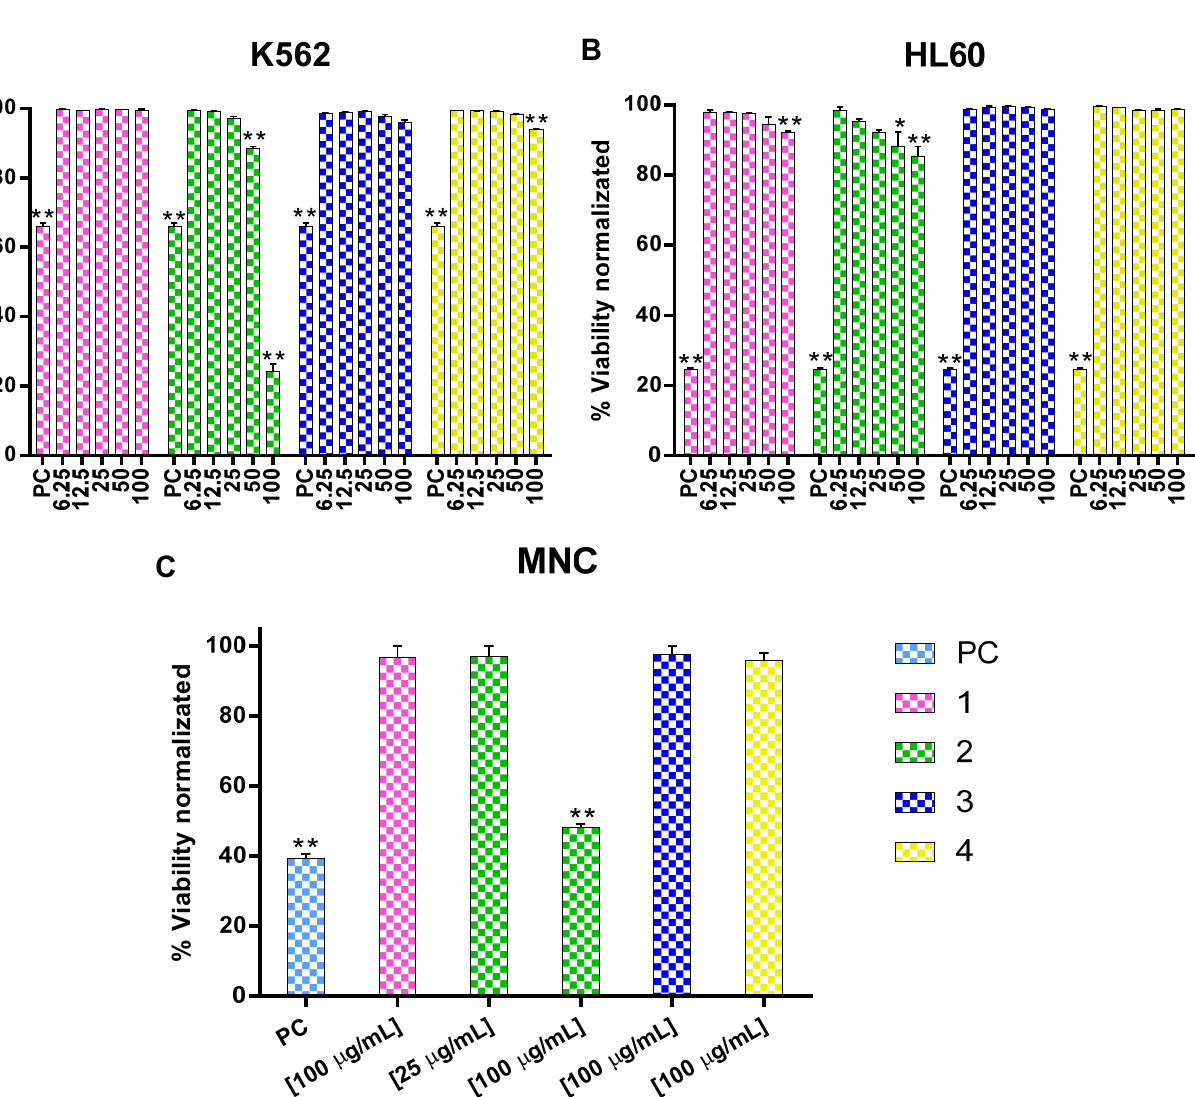
Figure 2. Effect of compounds 1 – 4 at different concentrations in K562 ( A ) and HL60 ( B ) cell and normal MNC ( C ). Normal and leukemia cells were cultured in presence of different compounds concentration by 48 h and the viability percentage was analyze using 7-AAD. Data are expressed as the percentage of 7-AAD ± SEM positive cells from at least three different experiments in triplicate. Statistical significance was determined by a one-way analysis of variance (ANOVA) followed by Dunnett’s post-hoc test . The differences were considered significant * p < 0.05, ** p < 0.01 vs. negative control (NC).